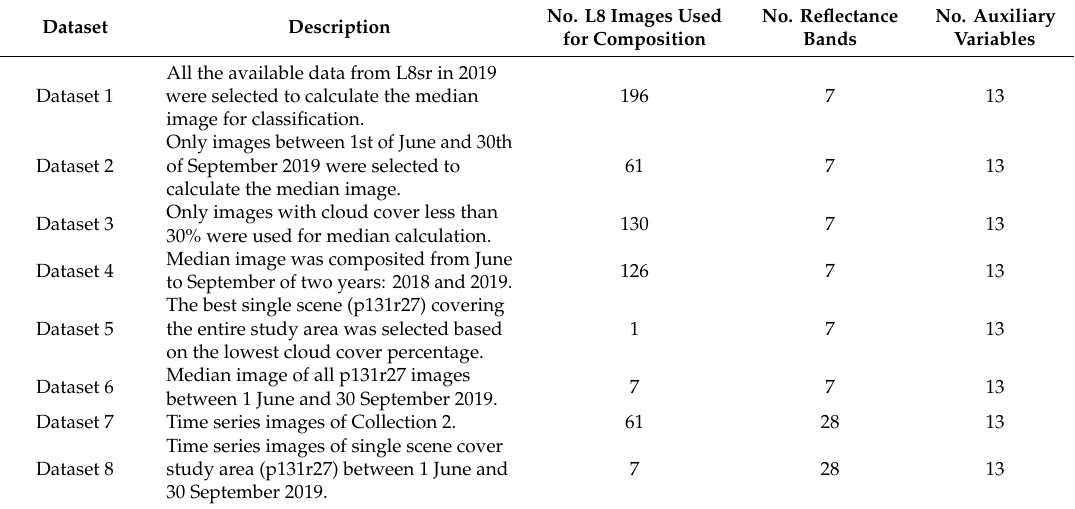
Table 1. The composition of the eight datasets used for classification and